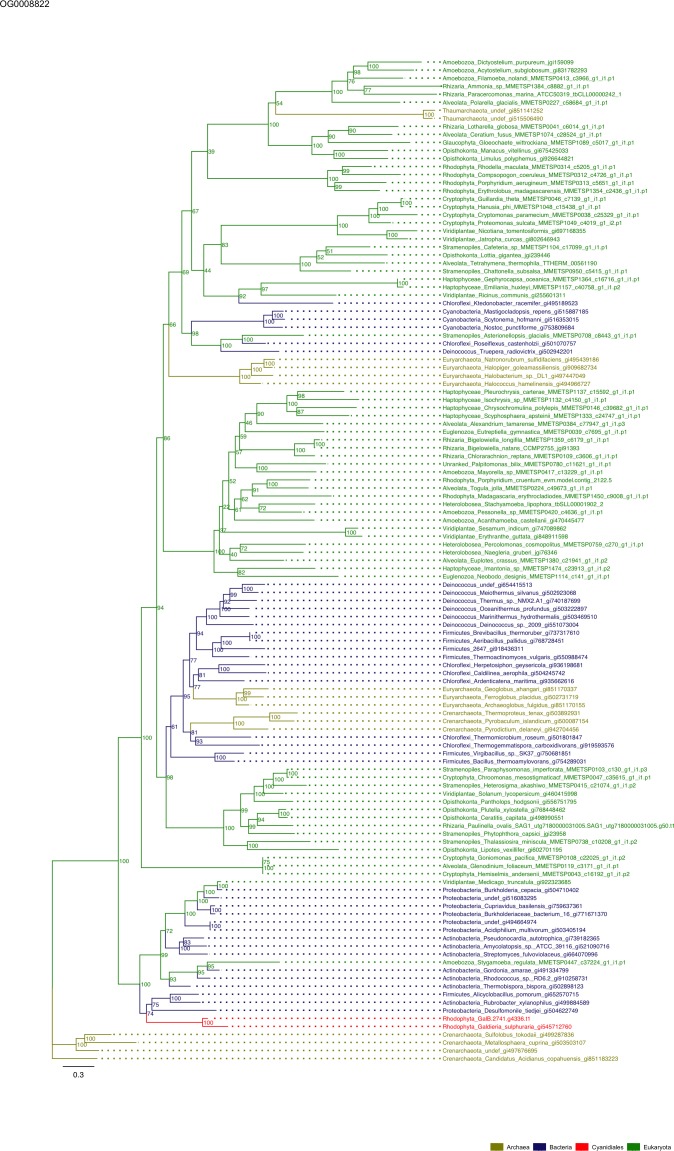
Sequence tree of orthogroup OG0008822.The tree is based on amino acid sequences. Archaea (yellow), Bacteria (blue), Cyanidiales (red), Eukaryotes including other red algae (green). Branches containing Cyanidiales sequences are highlited in red.